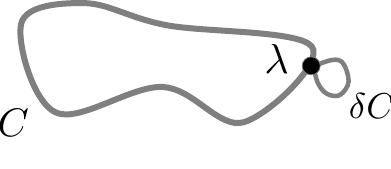
Figure 1: Adding a small loop δ C to the curve C at λ to take the area